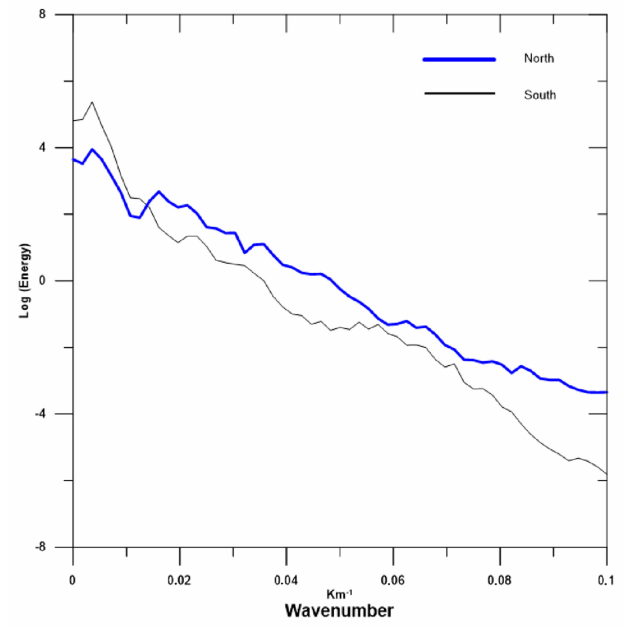
Figure 6. Radial average spectrum applied on the area located north (in blue) of the black continuous line (Figure 5b) and south (in black) of